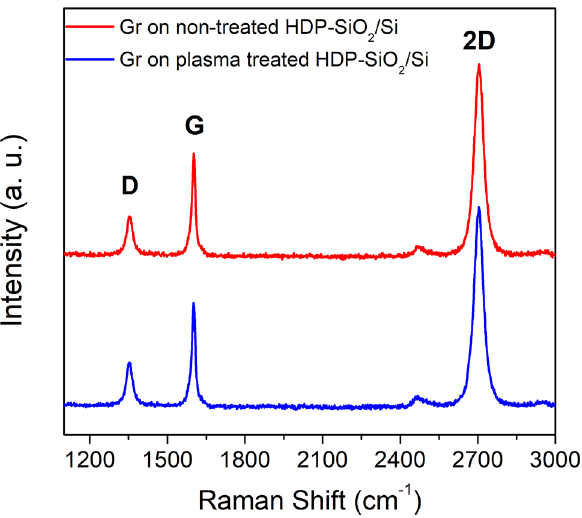
Figure 4. Raman spectra for graphene transferred on plasma treated HDP-SiO 2 /Si (blue curve) and on non- treated HDP-SiO